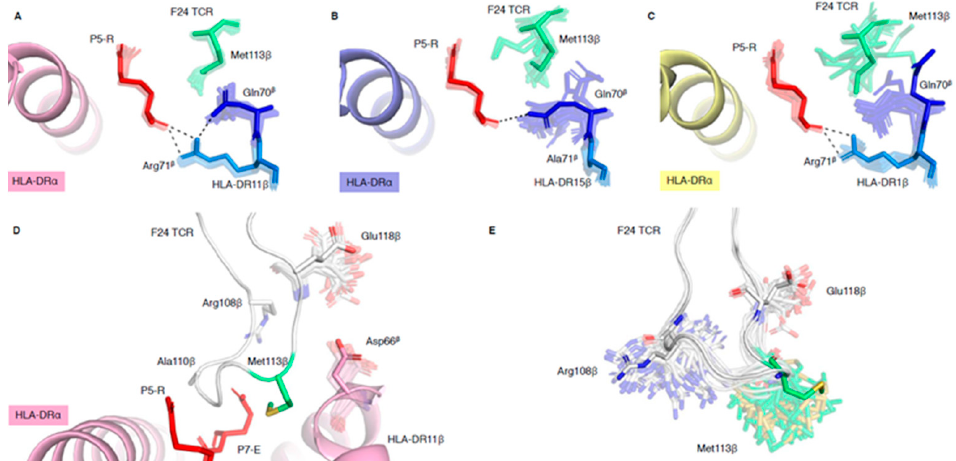
Figure 3. Spatial variation of side chains that form the F24 TCR Met113 β peg-notch interaction. ( A ) Ensemble results of a stable peg-notch interaction in HLA-DR11-RQ13 (pale pink HLA-DR α ), and disrupted peg-notch interaction, due to conformational variation of polymorphic residues, in ( B ) HLA-DR15-RQ13 (pale purple HLA-DR α ), and ( C ) HLA-DR1-RQ13 (yellow HLA-DR α ). These side chain interactions (dash lines) between HLA-DR β 70 (blue), HLA-DR β 71 (light blue) and P5-R (red) destabilise Met113 β binding (green). ( D ) Ensemble results showing steric clashes between HLA-DR11 Asp66 β (pale pink) and F24 TCR Glu118 β (white) that a ff ect binding. ( E ) Ensemble results of CDR3 β loop residues derived from the crystal structure of F24 TCR free (PDB ID: 6CPH) showing a high level of conformational variation for Met113 β , Arg108 β and Glu118 β